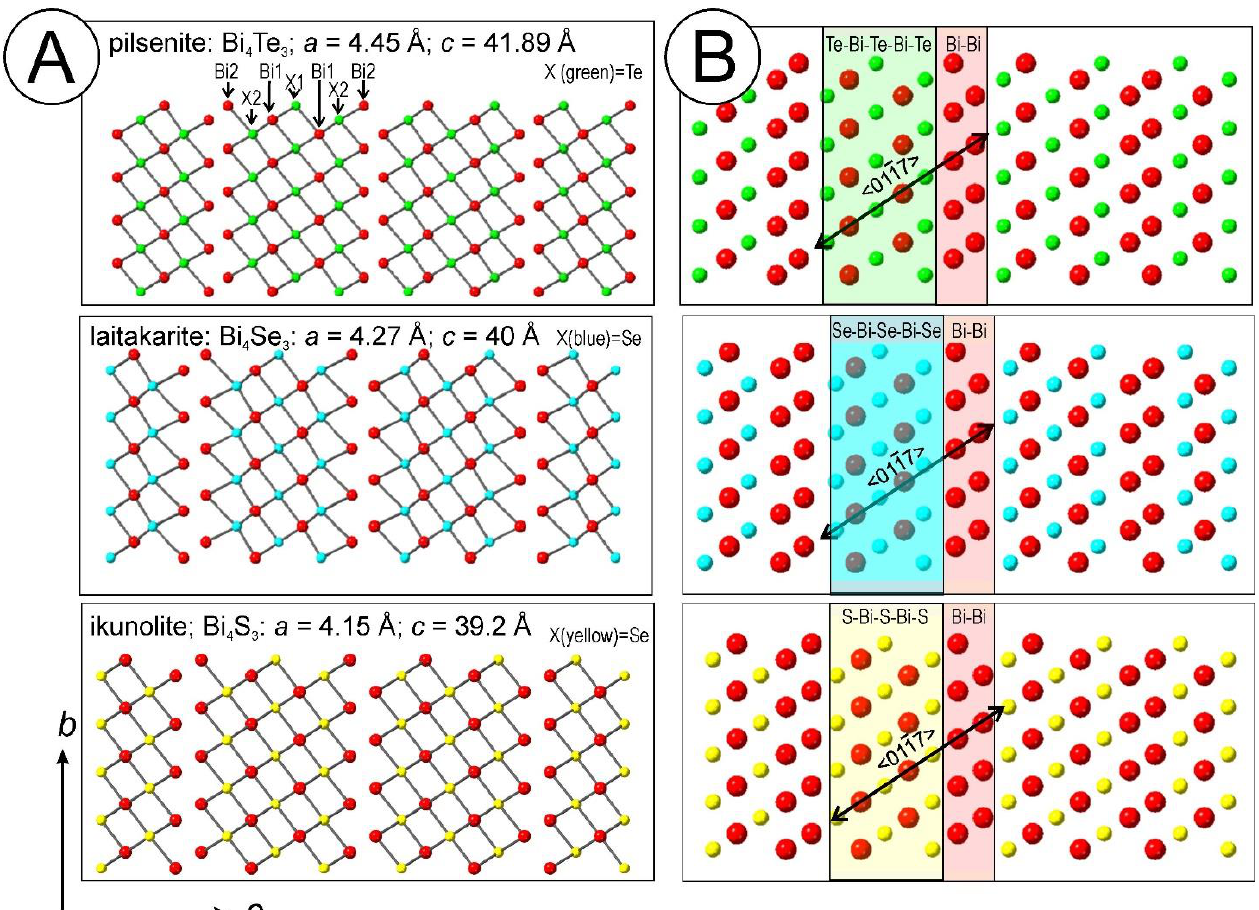
Figure 1. Ball-and-stick ( A ) and space filling ( B ) crystal models for pilsenite, laitakarite, and ikunolite viewed along the a axis. The three minerals are isostructural with slightly modified a and c dimensions. The two structural positions for Bi and chalcogen (X = Te, Se, S) are schematically marked at the top. Structures constructed in CrystalMaker ® (v10.5.7) using .cif files based on Yamana et al. [23] for pilsenite (Bi 4 Te 3 ), Stasova [24] for laitakarite (Bi 4 Se 3 ), and Kato [25] for ikunolite (Bi 4 S 3 ).